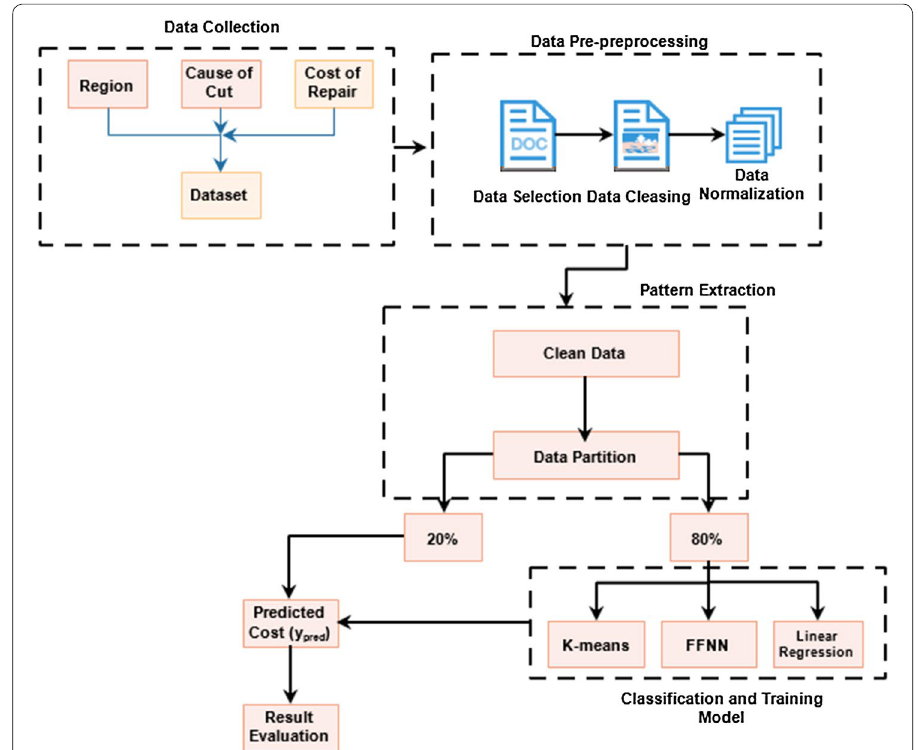
Fig. 4 Conceptual model for the prediction of